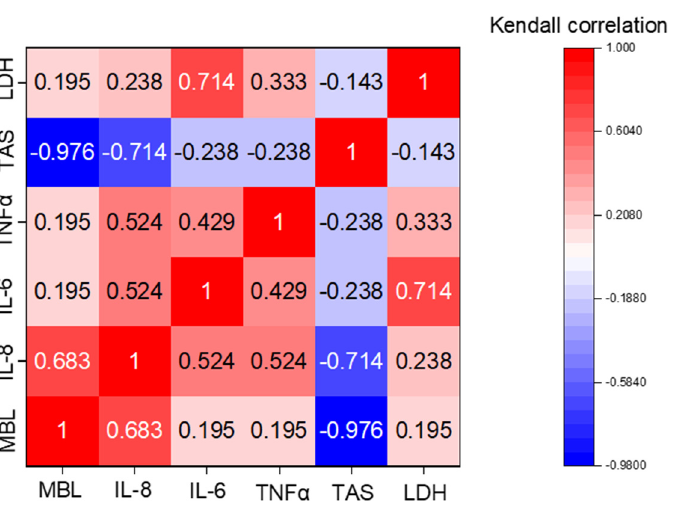
Figure 4. Analysis of correlation between one-year peri-implant bone loss (MBL) and the amount of IL-6, IL-8 and TNF- α (tumor necrosis factor), total antioxidant activity (TAS) and salivary lactate dehydrogenase levels (LDH) for patients included in Group 1. The positive correlation is displayed in red and the negative correlation in blue.